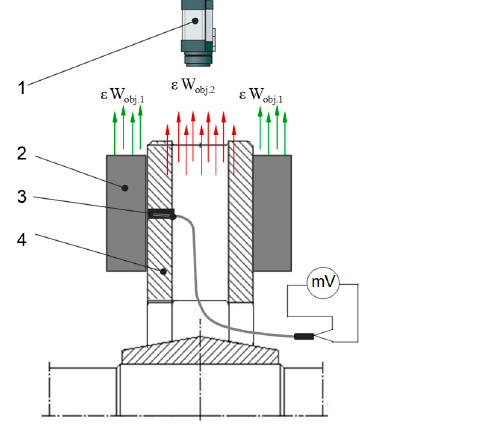
Figure 1. Railroad disc brake testing stand: ( a ) view to the working part of the brake stand with rotating masses, ( b ) view to the tested brake disc with thermovision measurement, ( c ) view of the stand.